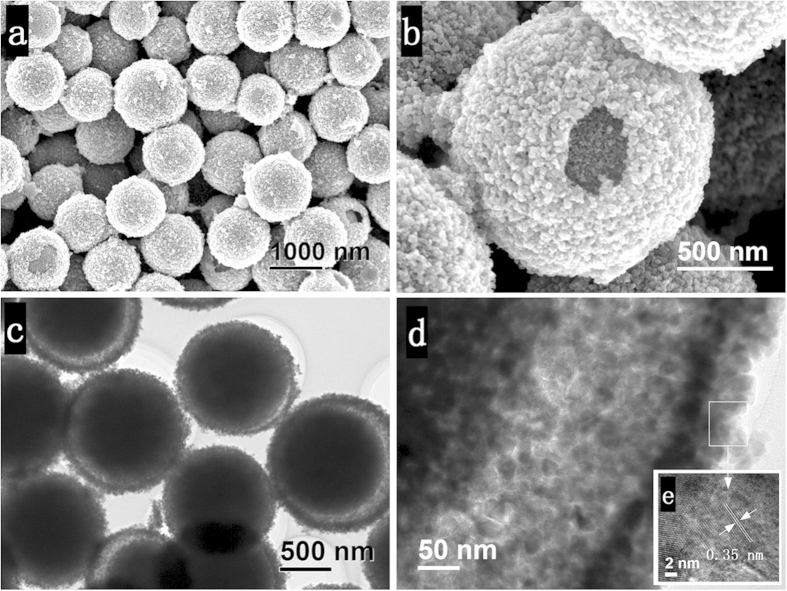
Morphology of the TiO2 yolk-shell structure.(a,b) SEM, (c,d) TEM and (e) HRTEM images of the TiO2 yolk-shell microspheres synthesized at 200 °C for 6 h.